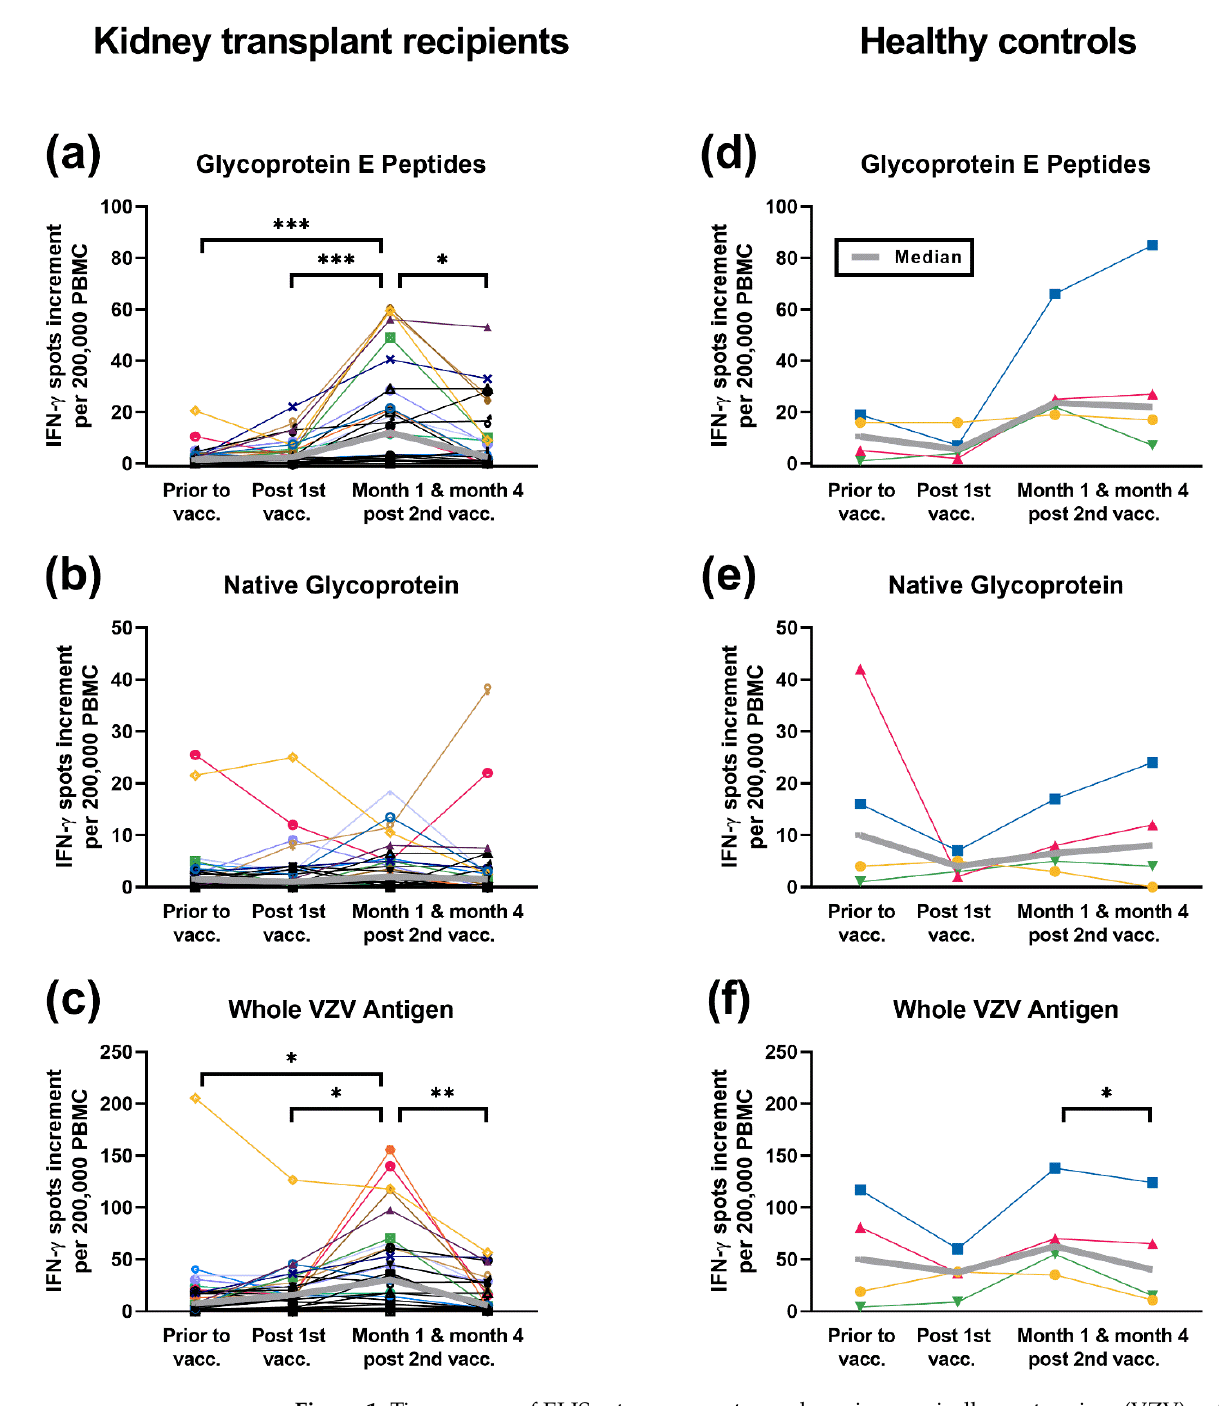
Figure 1. Time course of ELISpot responses towards various varicella–zoster virus (VZV) antigens in 29 kidney transplant recipients ( a – c ) and in four healthy controls ( d – f ). We used a peptide pool of glycoprotein E ( a , d ), a native glycoprotein ( b , e ), or a whole VZV antigen ( c , f ) for in vitro stimulation of peripheral blood mononuclear cells (PBMCs). Data prior to and post vaccination (vacc.) with Shingrix™ were compared by using one-way ANOVA with Tukey’s multiple-comparison test (* p < 0.05, ** p < 0.01, *** p < 0.001). VZV-specific spots were determined as stimulated minus non-stimulated (background) values (spot increment). The data for each individual is coded by the same color and symbol used consistently in panels ( a ) to ( c ) or ( d ) to ( f ). The bold gray line connects the median values.